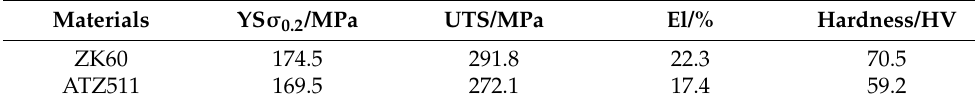
Table 2. Mechanical properties of ZK60 and ATZ511 magnesium alloys.